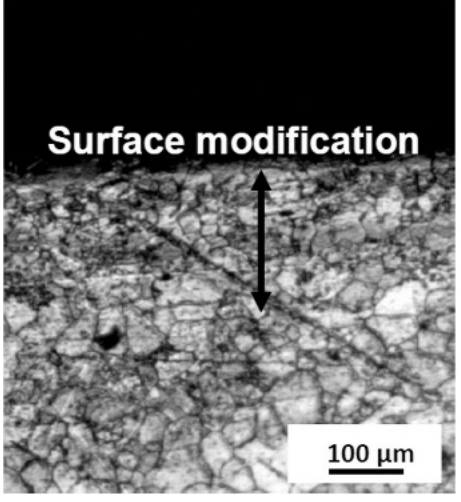
Figure 2. Microstructure change on the surface of the IF steel upon LSP [75]. Chu et al. [76] demonstrated the effect of LSP on microstructure modification in low ‐ carbon steel: SAE1010 (C < 0.04). For LSP, they used Nd: glass phosphate laser (pulse du ‐